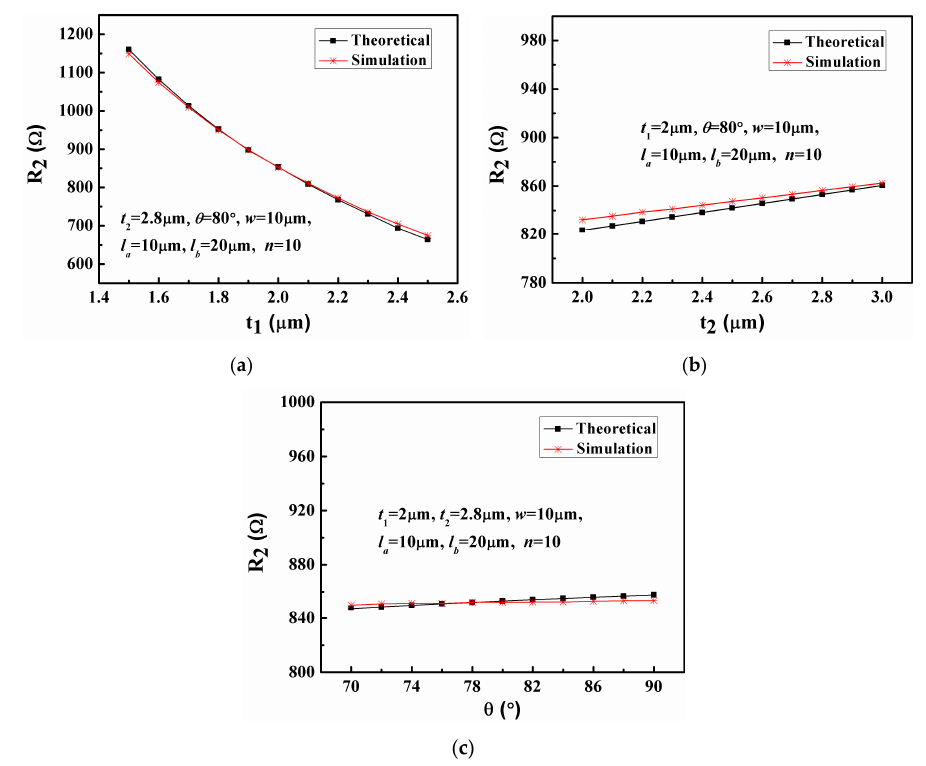
Figure 7. Theoretical and simulation results of the relationship between R 2 and the geometrical parameters: ( a ) The thickness of the polysilicon layer ( t 1 ); ( b ) The thickness of the PSG layer ( t 2 ); ( c ) The sidewall etch angle of the PSG layer ( θ ).